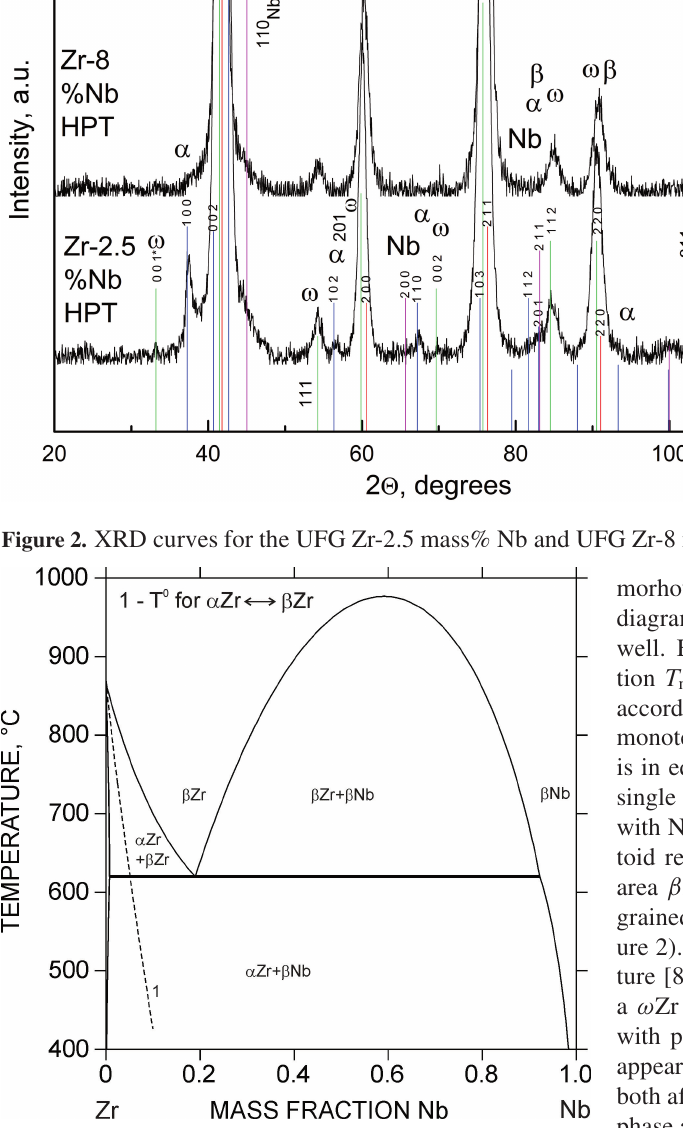
Figure 3. The part of the Zr-Nb equilibrium phase diagram. Dashed line shows the martensitic martensitic ˛ Zr $ ˇ Zr